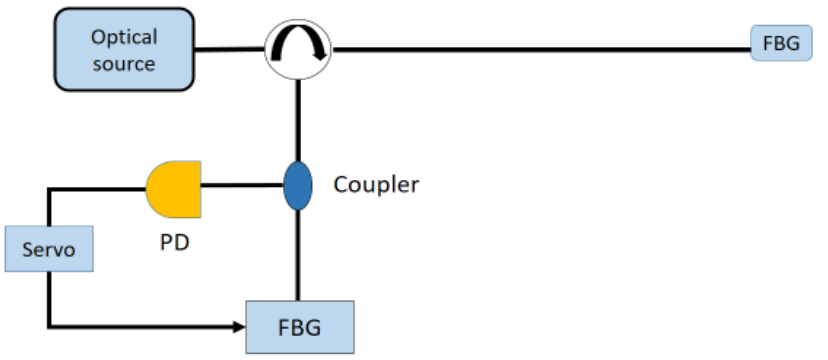
Figure 17. Example of an experimental set-up for active bandpass filtering interrogation technique.